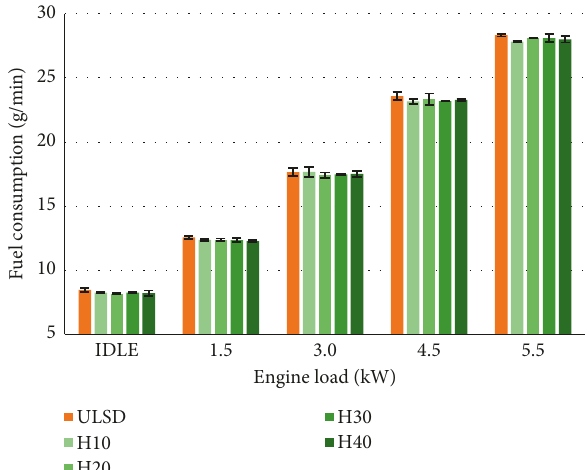
Figure 8: Gravimetric fuel consumption for ULSD and HUCO blends for all loads.